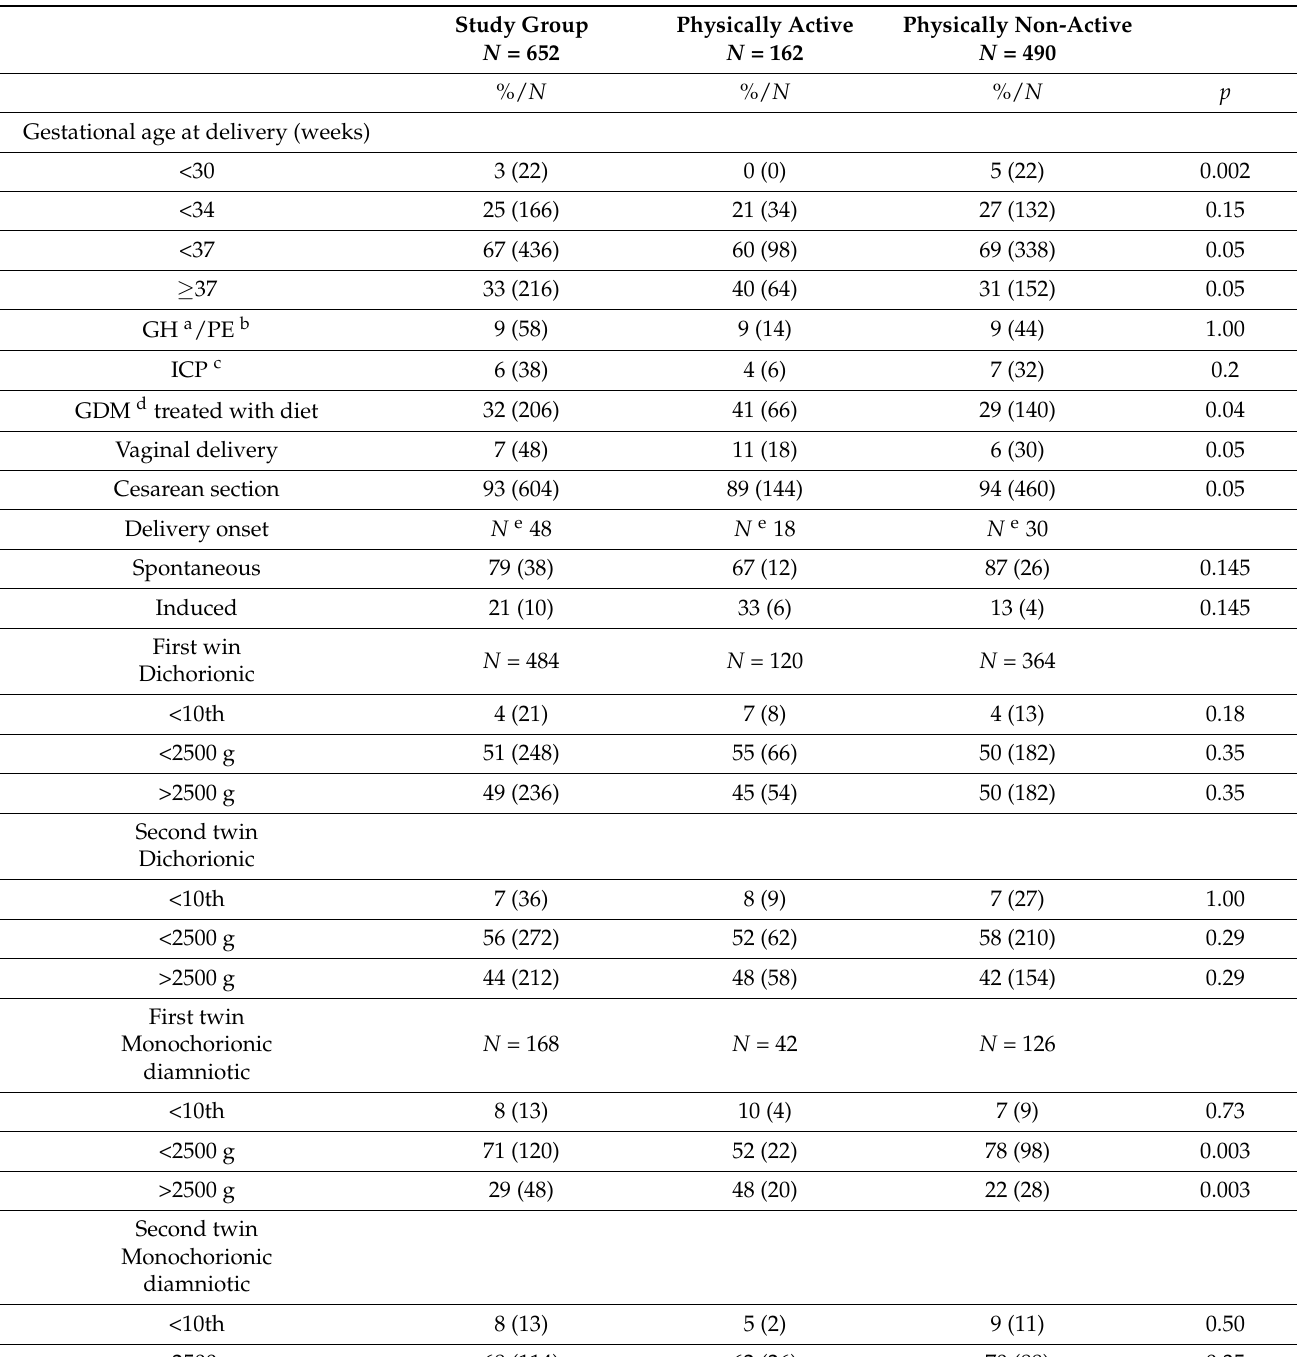
Table 3. Delivery and neonatal birthweight in physically active and non-active respondent